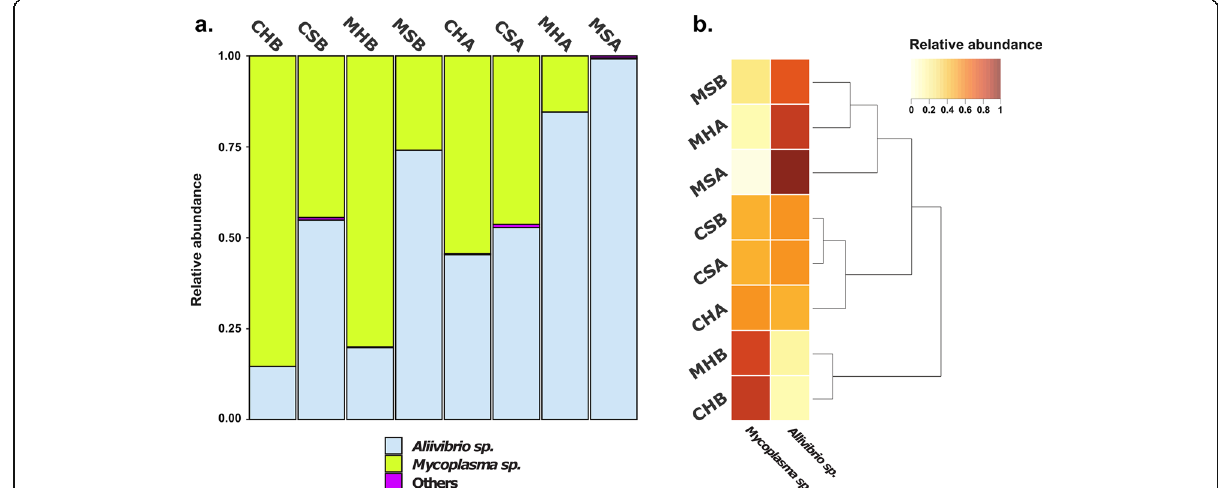
Fig. 3 Microbial composition of the investigated groups and groups beta diversity. a Barplots depicting the microbial composition of the investigated groups (see Fig. 1 for definition) shows that they are dominated in the composition by two OTUs: Aliivibrio sp. and Mycoplasma sp. Specific shifts in the relative abundance of the two highly abundant OTUs across groups are visualized. b Clustering based on beta diversity (represented as a dendrogram) is mainly determined by the relative abundance of the two dominating OTUs as shown by the